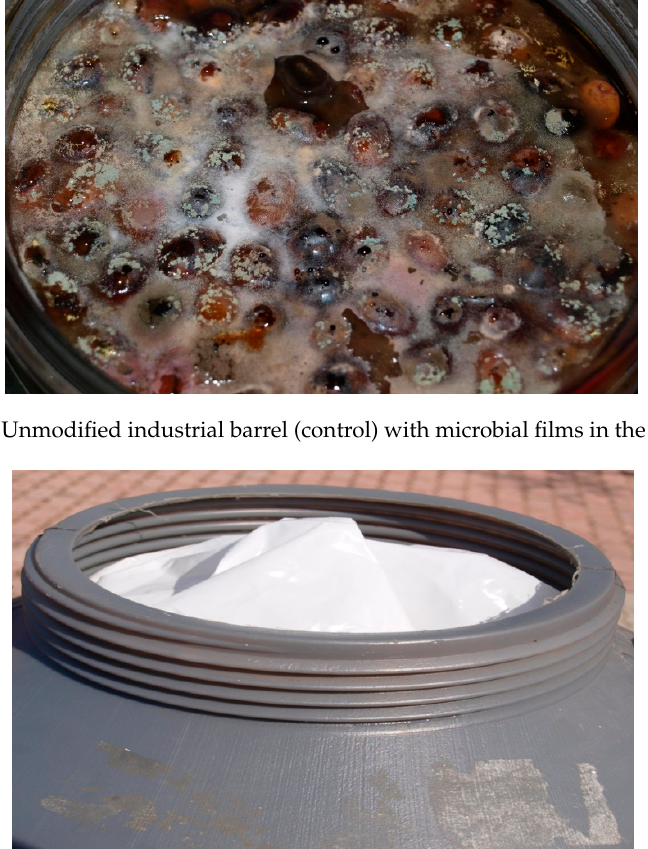
Figure A2. Modified industrial barrel with air-protected headspace. Figure A3. Modified industrial barrel with air-protected